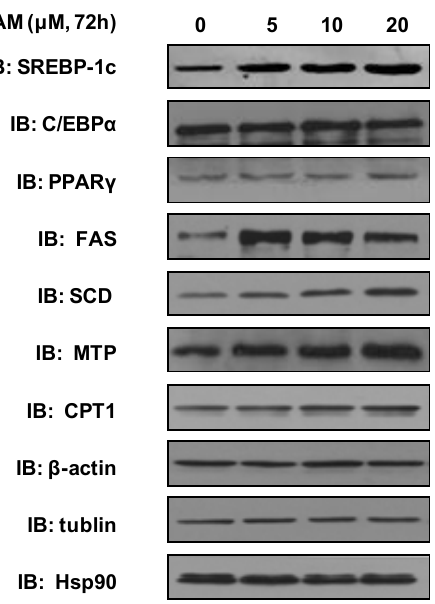
TAM was not due to increased cell proliferation. However, we observed that a high dose (over 20 μM) of TAM had a cytotoxic effect (data not shown) on HepG2 cells. Figure 4. The effect of increasing concentrations of TAM on the expressions of proteins (SREBP-1c, C/EBPα, PPARγ, FAS, SCD, MTP and CPT1) involved in lipid homeostasis in HepG2. Hepatocytes were incubated with 0, 5, 10 and 20 μM of TAM for 72 h, respectively, and then collected for Western blot analysis. Experimental procedures are shown in the Materials and Methods section (IB: immunoblot).